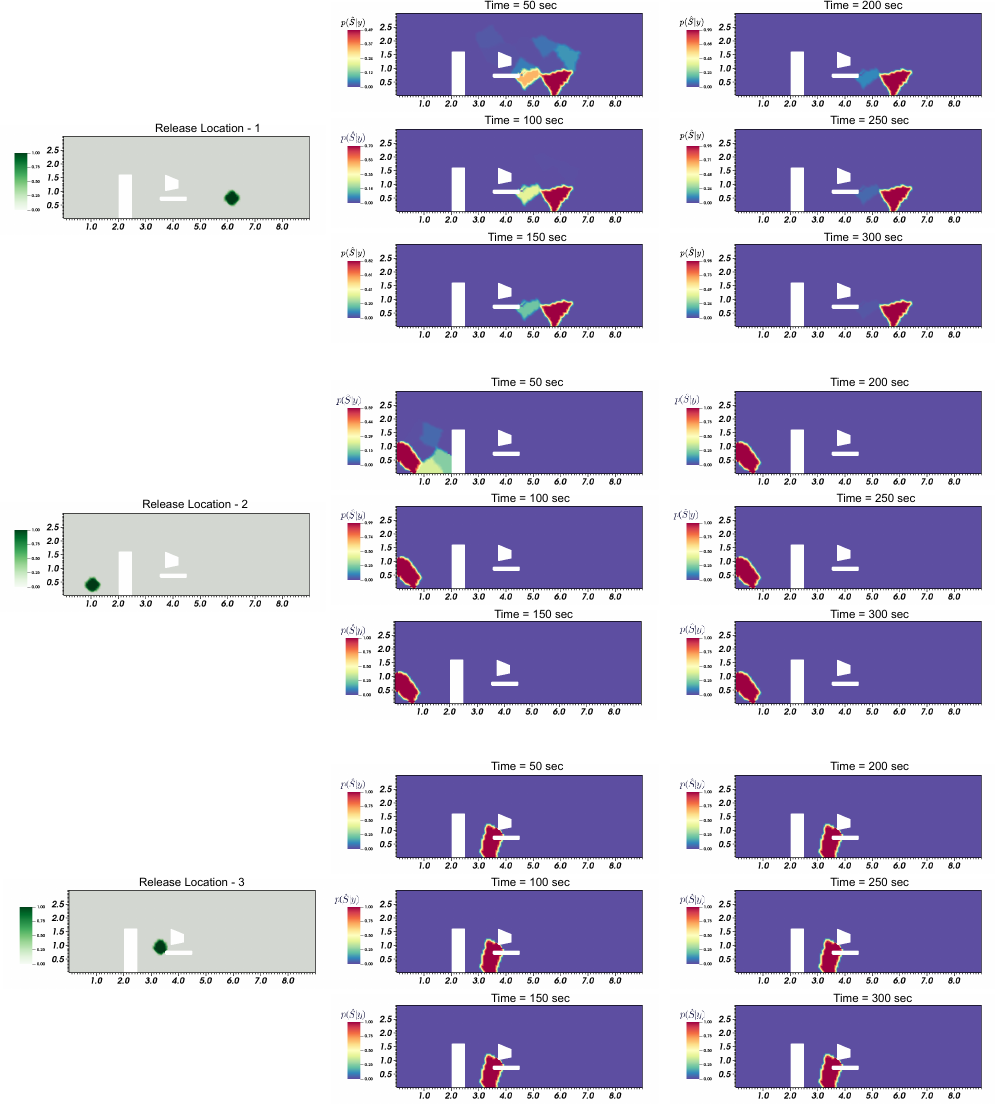
Figure 6. Bayesian inference is posterior for three random releases at every observation time